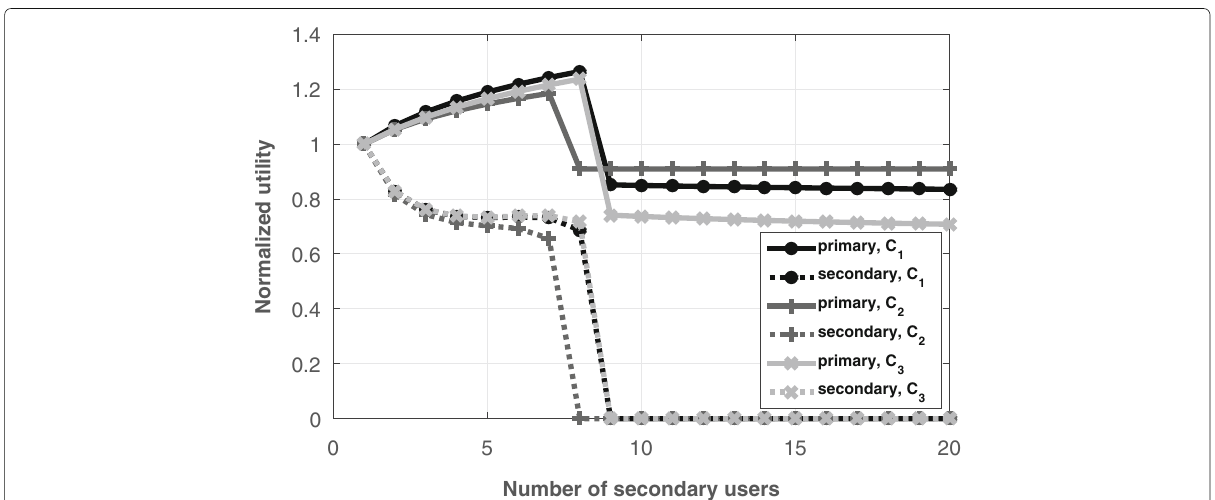
Fig. 8 The two players’ normalized utilities versus the number of secondary users with n p = 2, λ p = 10 kbps, λ s = 1 kbps, and μ = 100 kbps and three cost functions with C 1 , C 2 , and C 3 defined by Eqs. 11, 22, and 23, respectively